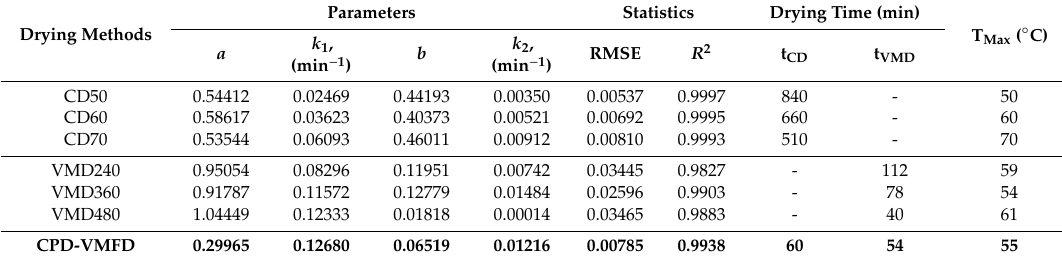
Table 1. Model parameters ( a , k 1 , b , k 2 ); maximum temperature of the hemp flowers during drying (TMax); and drying times t CD and t VMD of CD and VMD,